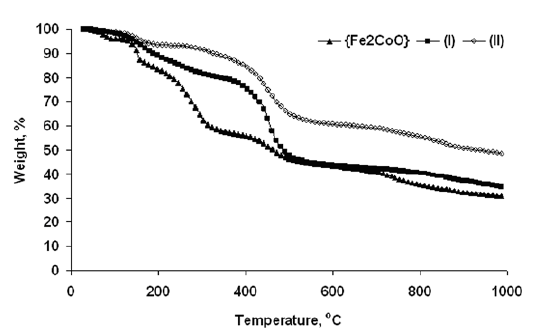
Figure 2. TG curves of investigated compounds, {Fe and II .